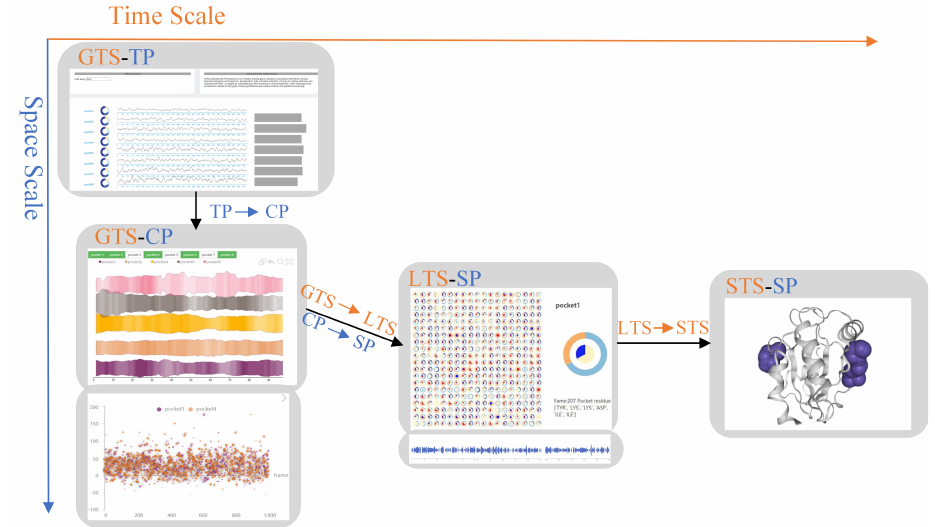
Figure 14. Classification according to the different scales. The horizontal axis direction is divided into three scales according to time scales. The vertical axis is divided into three dimensions according to space scales. The arrows represent the interaction